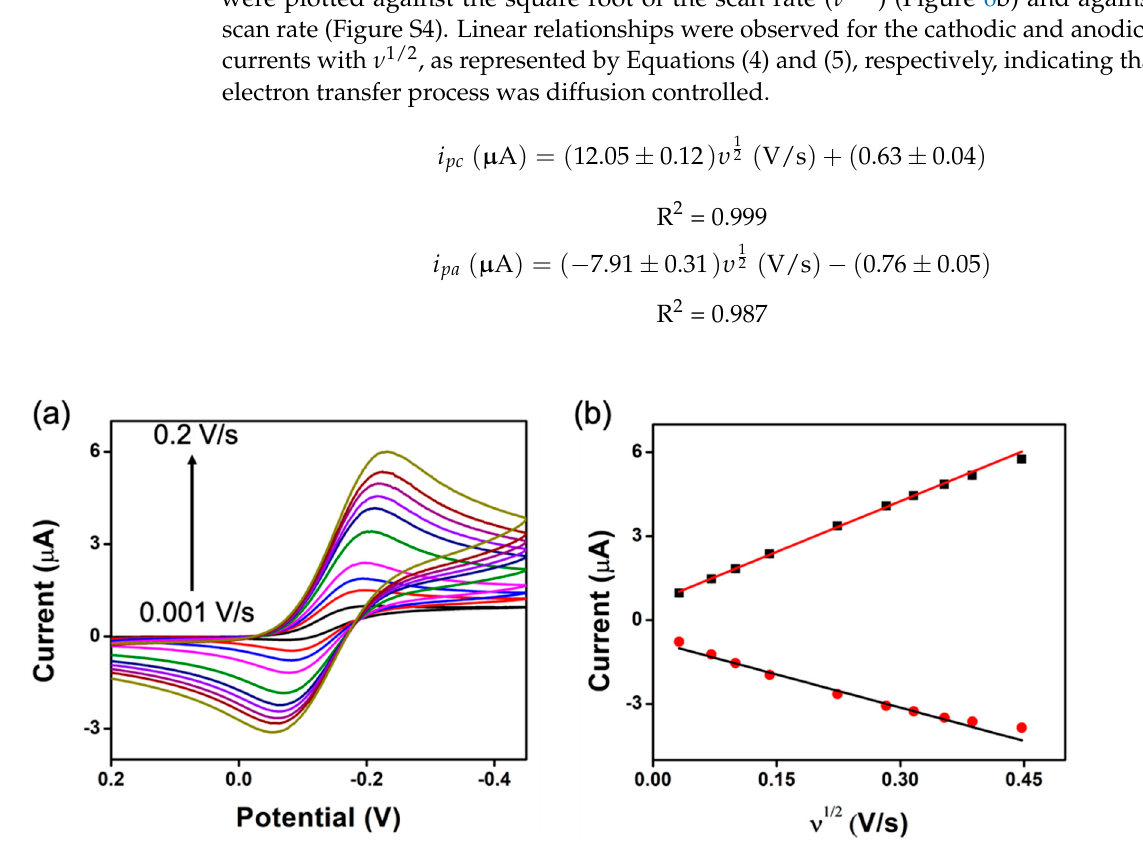
Figure 6. Scan rate study of the CNT-NEE. ( a ) Cyclic voltammograms collected at scan rates of 0.001, 0.005, 0.01, 0.02, 0.05, 0.08, 0.1, 0.125, 0.15, and 0.2 V/s in 2.5 mM Ruhex and 25 mM KCl. ( b ) i p vs. υ 1/2 plots (black squares: i pc ; red circles: i pa ) the CNT-NEE (n = 3).